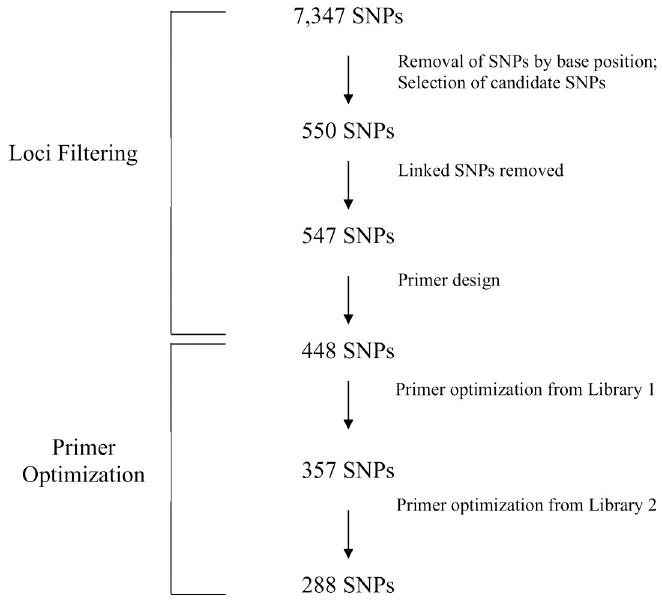
Fig 3. Workflow of initial Oncorhynchus nerka multi-use panel design and primer removal.